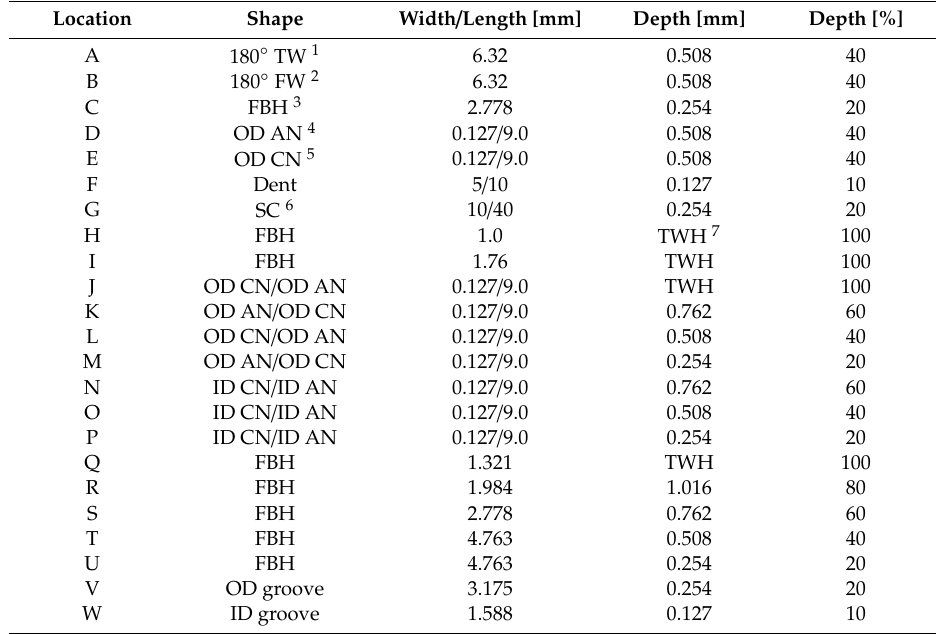
Figure 3. Test specimens (unit: mm). Table 1. Specifications of